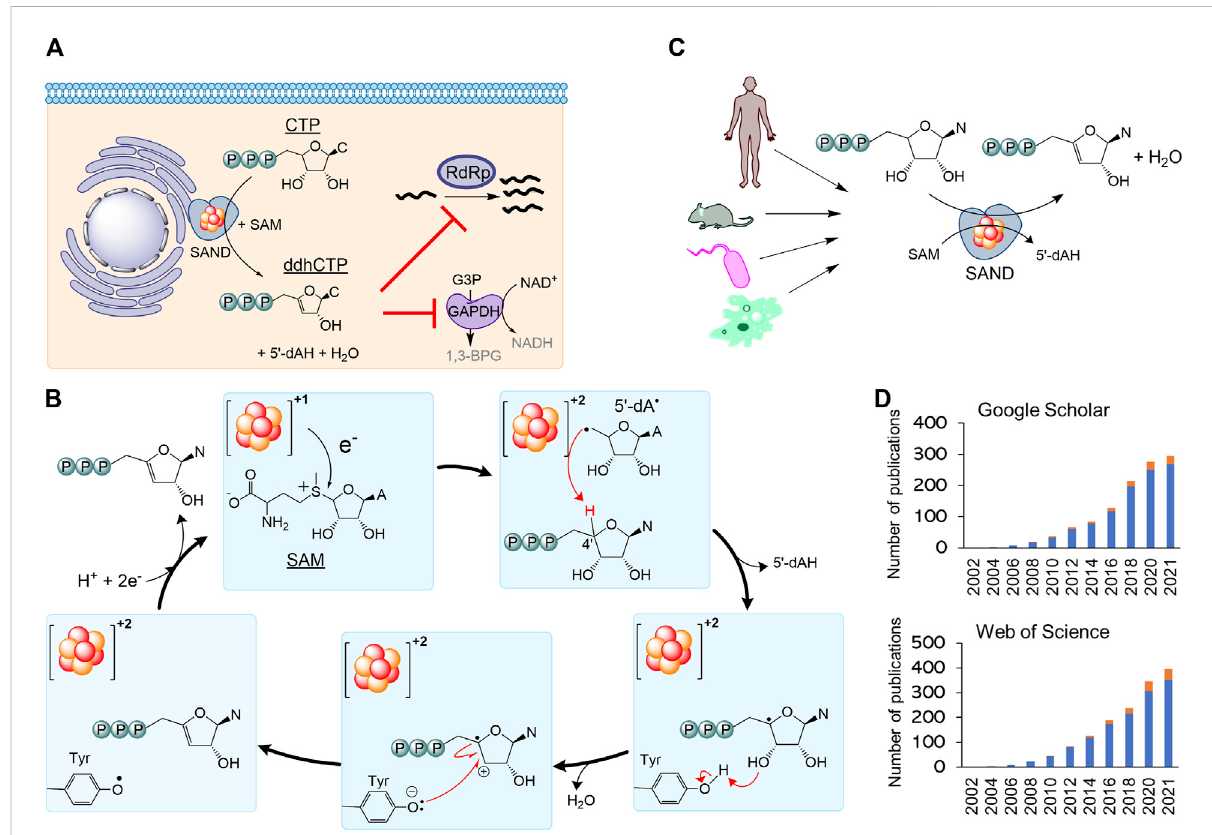
FIGURE 2 The nomenclature SAND (SAM-dependent Nucleotide Dehydratase) de fi nes chemistry relevant to biology across all domains of life. (A) SAND produces the nucleoside triphosphate analogue ddhCTP in humans. ddhCTP modulates metabolism affecting cell function and restricting viral replication. (B) The proposed mechanism of dehydration of nucleoside triphosphates by SAND. The mechanism shows the transfer of a proton and an electronfrom aconserved tyrosine. Alternatively, it is possible that proton transfer occurs via another amino acid residue. It is not clear ifthe transfer of proton and electron occurs simultaneously (proton-coupled electron transfer). (C) SANDs from various organisms produce diverse ddh analogues. (D) An increasing number of investigators study SANDs. The data were obtained from asearchof nomenclature viperin and RSAD2 in